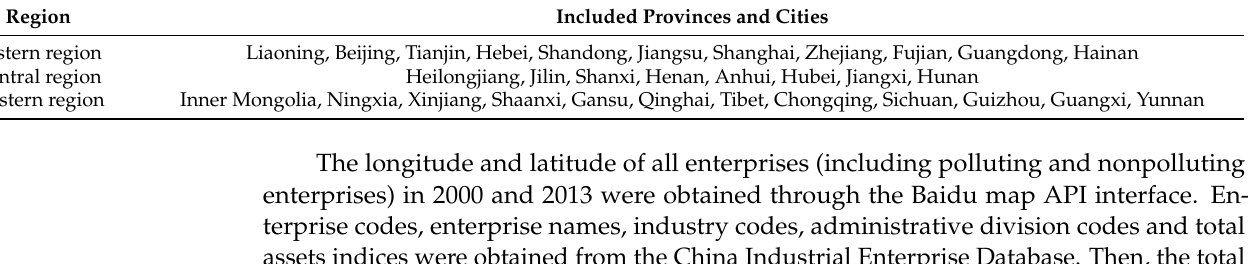
Table 1. Regional division of China. Region Included Provinces and